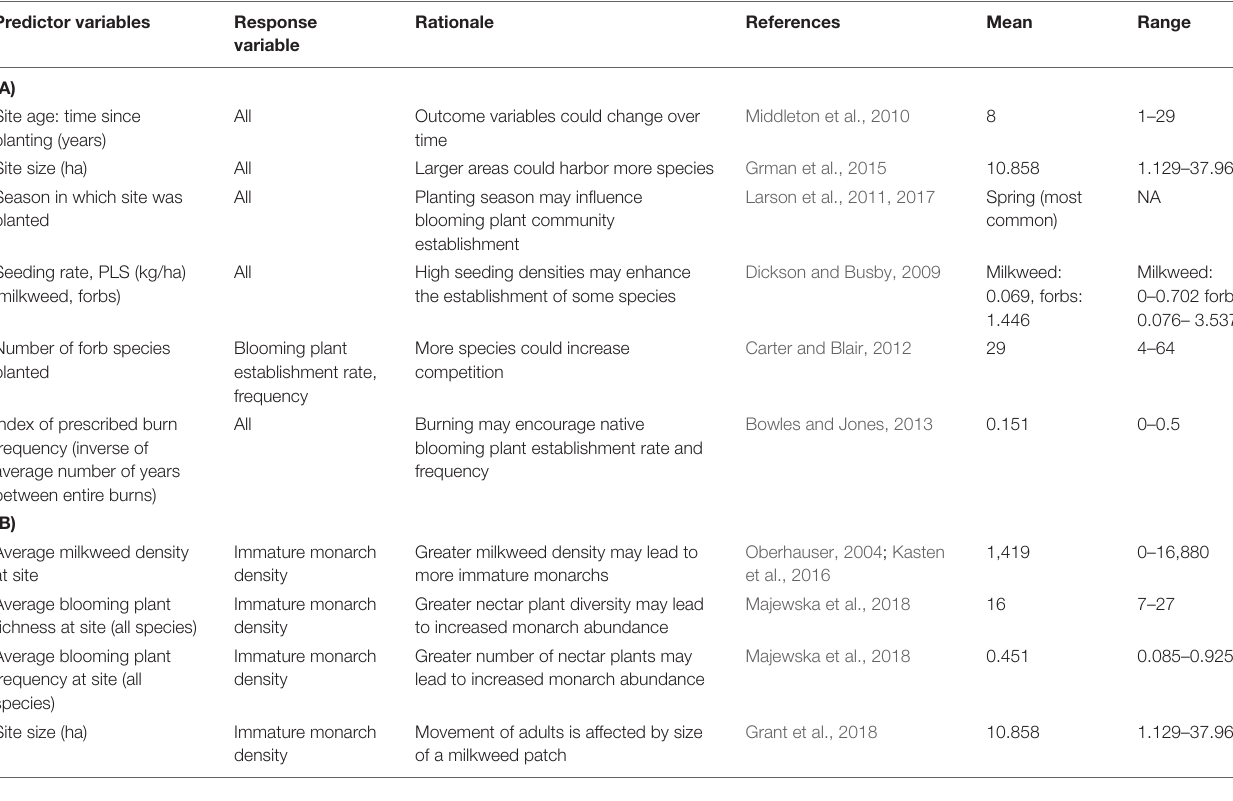
TABLE 1 | (A) Planting and post-planting management variables included in analyses of milkweed density, blooming plant frequency (planted forb species only), and blooming plant establishment rate. (B) Predictor variables included in immature monarch density analysis. Predictor variables